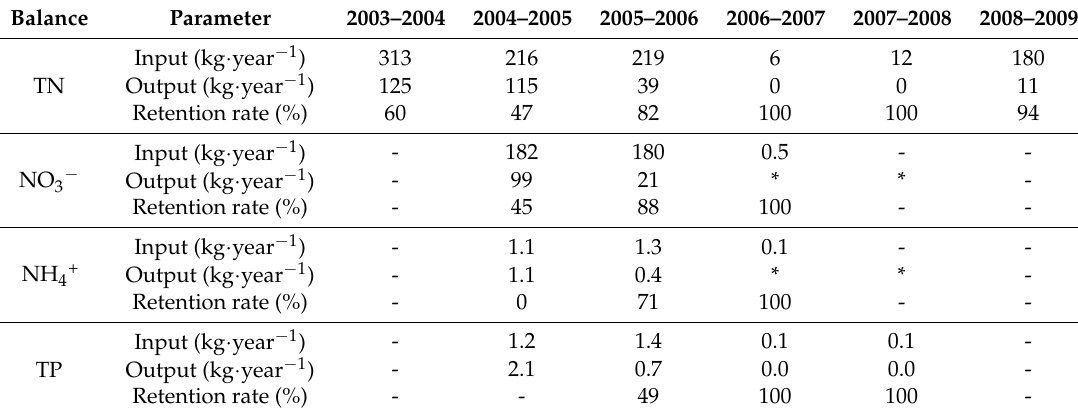
Table 2. Nutrient balance of the monitored CW with the atmosphere input considered.